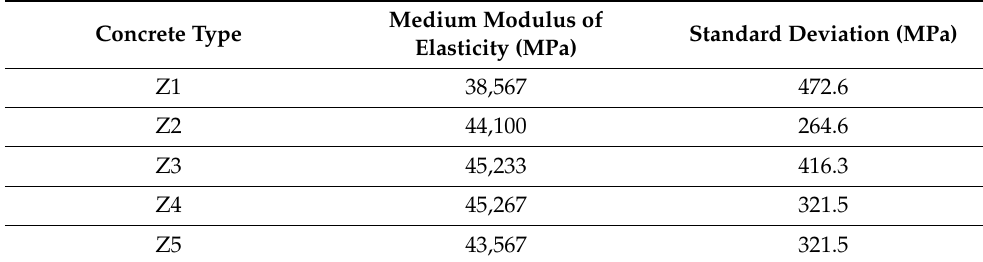
Table 10. Results of the classical elastic modulus test.